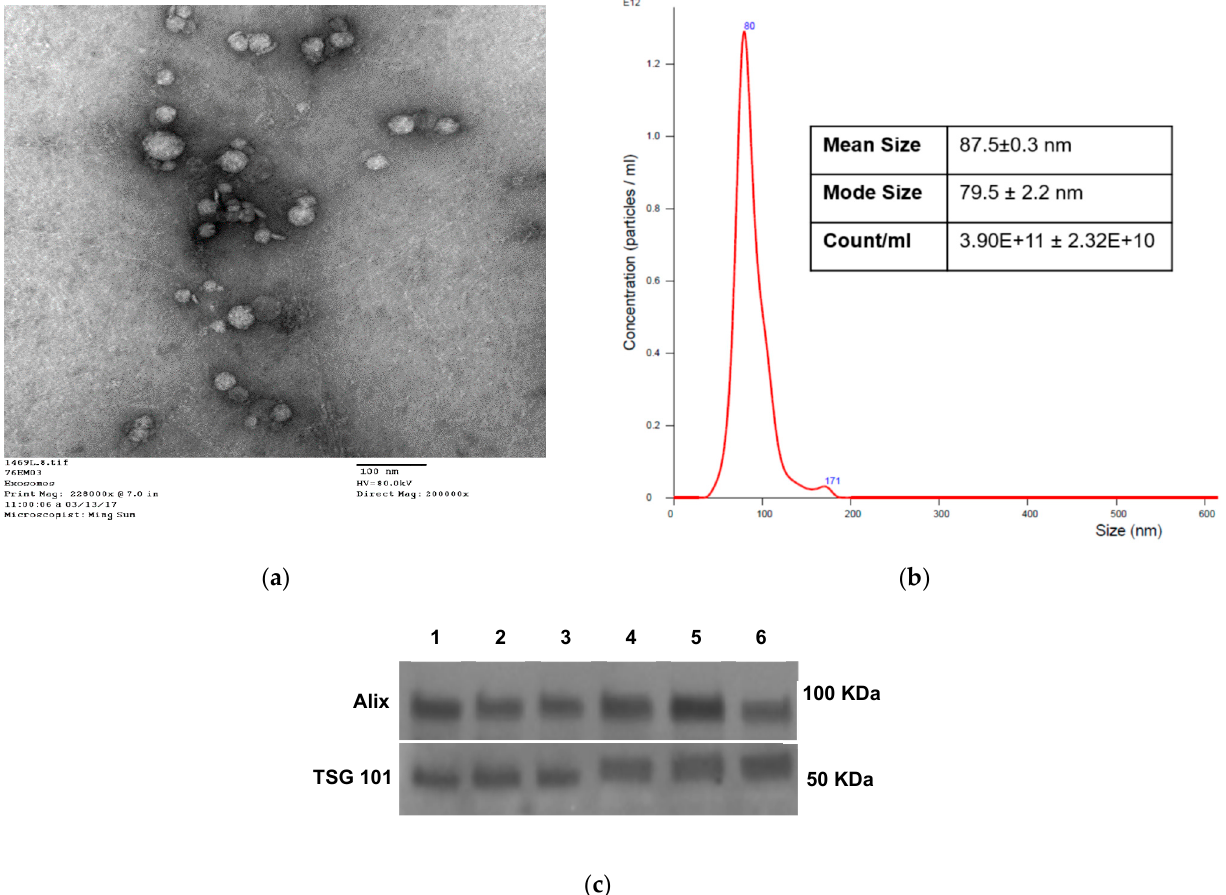
Figure 1. Characteristics of sEV isolated from NSCLC plasma. ( a ) Transmission electron microscopy of isolated NSCLC exosomes. ( b ) Size and concentration of NSCLC exosomes as determined by tunable resistive sensing (TRPS). ( c ) TSG101 and ALIX detection by Western blots in sEV isolated from plasma of several different patients with NSCLC. Each lane was loaded with 10 µg sEV protein present in fraction #4.